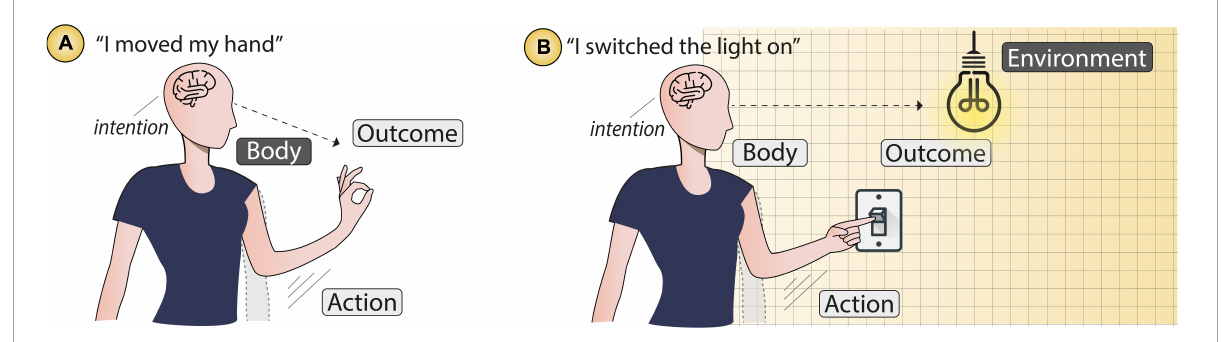
FIGURE2 Elements that compose the SoA. An intention to produce an outcome followed by the body moving to perform the action that produces such outcome. (A) Body agency : the outcome occurs in the body itself (mainly movements). (B) External agency : the outcome occurs outside the body (in the